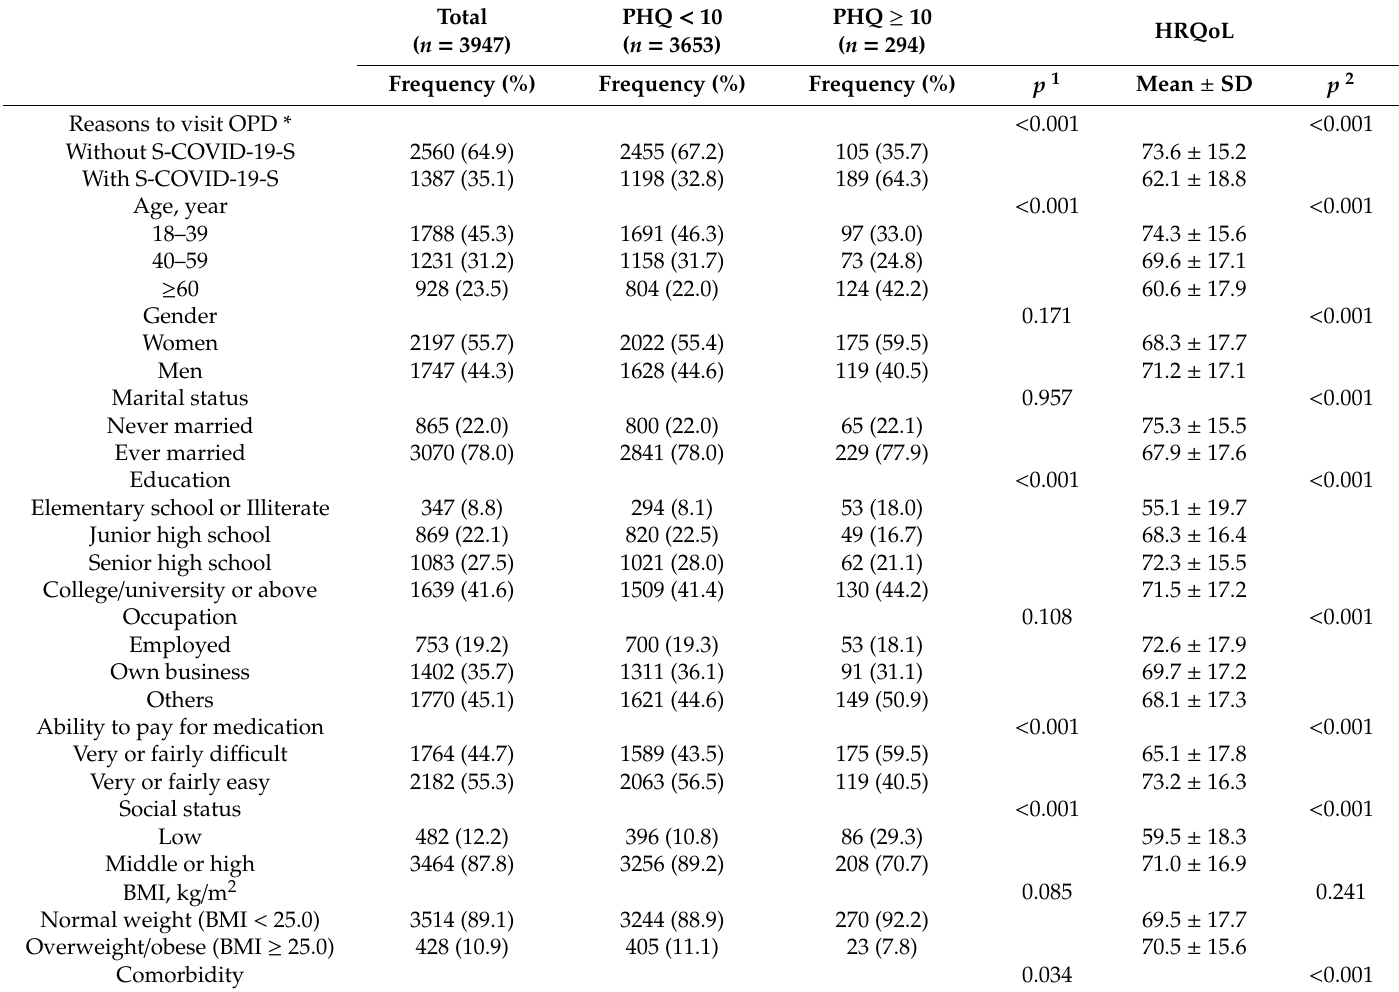
Table 1. Participants’ characteristics, health literacy index score, depression and health-related quality of life of